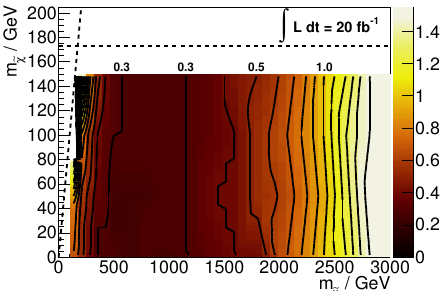
Figure 6. The minimal value in each model of the (cid:21) 0 is achieved. Contour lines are drawn at intervals of 0.1.